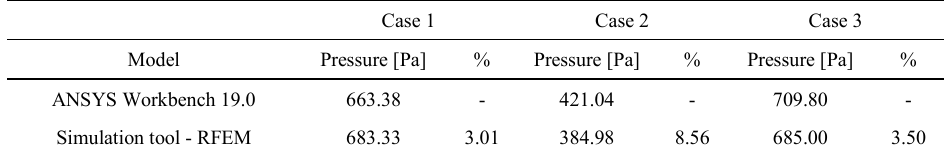
Table 3: Pressure applied on the inner pane. Cylindrical model.